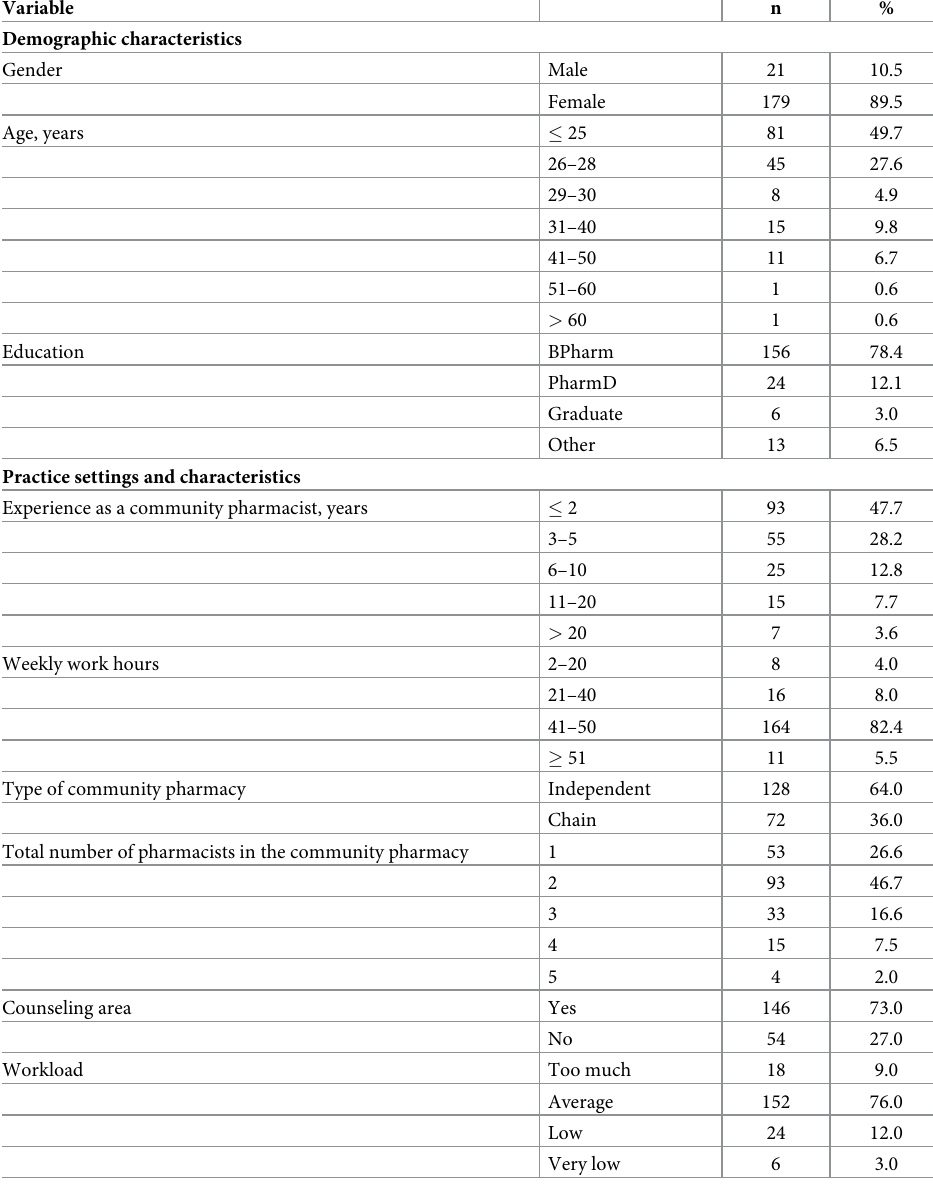
Table 1. Demographic and practice characteristics of the community pharmacists (N = 200). Variable n % Demographic